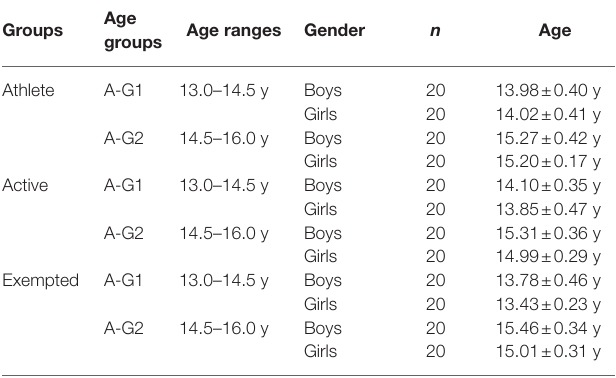
TABLE 1 | Distribution of population by physical activity level, age, and gender.